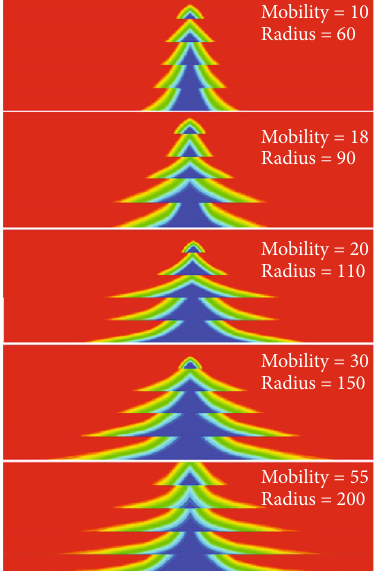
Figure 6: Physical simulation of water cone behavior under di ff erent